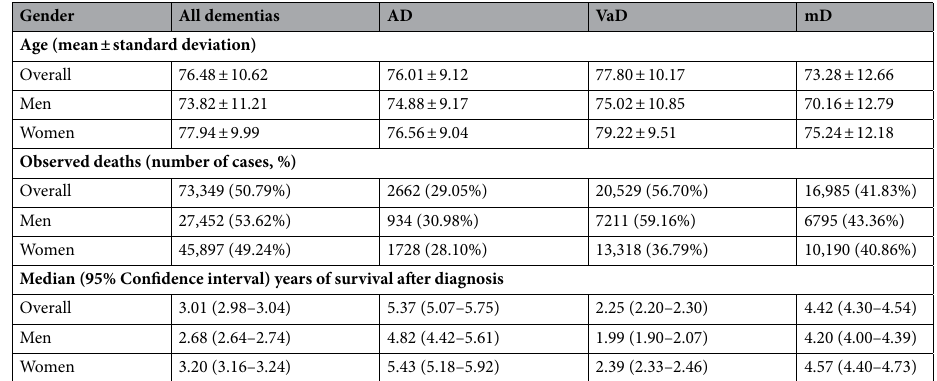
Table 2. Main features of dementia types. There was statistically significant difference in mean age by types of dementia and gender except AD (men) vs. VaD (men) as well as AD (men) and VaD (men) vs mD (women) (two-way ANOVA, post hoc Tukey HSD p < 0.0001). In the case of observed death, we compared the number of deaths over six years to the total number of patients. The median survivals were significantly different (log rank test p < 0.0001).